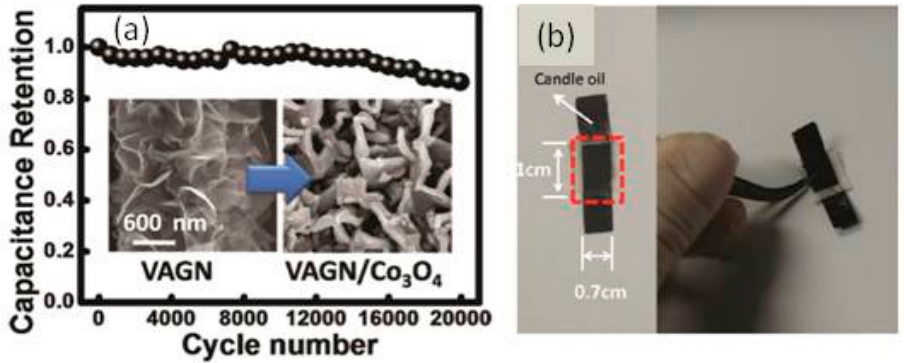
Figure 5. ( a ) High-resolution SEM images of the VAGN and VAGN/Co 3 O 4 . ( b ) Optical photographs of the fabricated solide-state supercapacitor device (reprinted from reference [78] with permission from the American Chemical Society. Copyright 2015).